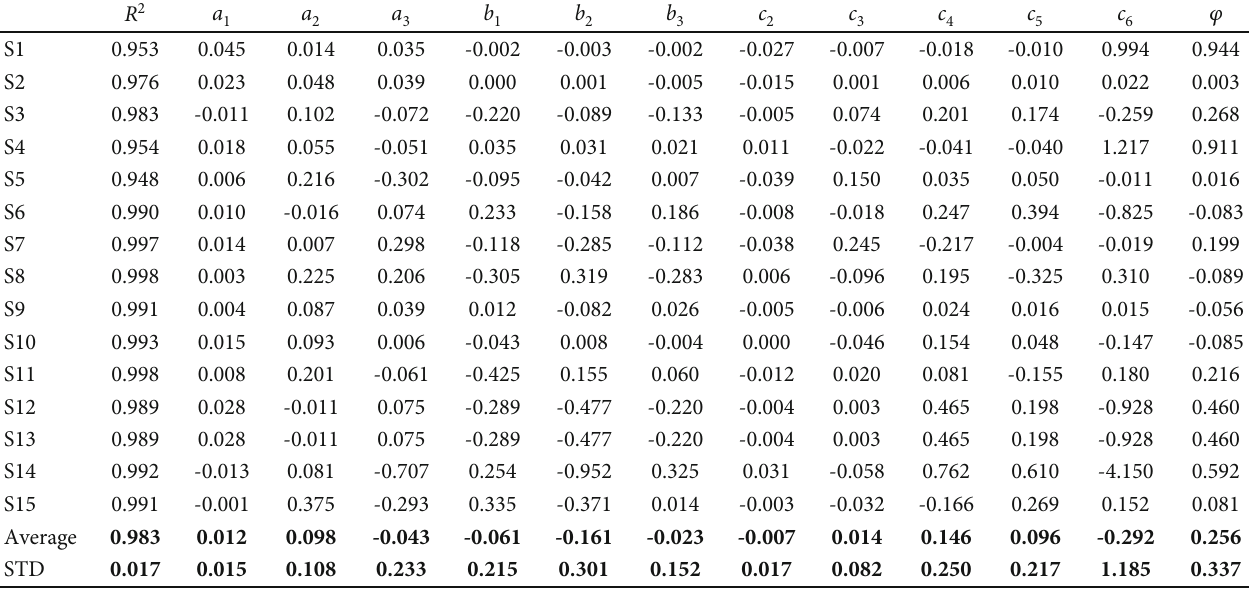
Table 5: Estimated material parameters of porcine sclera soft tissue loaded biaxially using polynomial (anisotropic) hyperelastic constitutive model including the coe ffi cient of determination ( R 2 ) of each specimen ( N = 15 ). The average constitutive ( a 1 , a 2 , a 3 , b 1 , b 2 , b 3 , c 2 , c 3 , c 4 , c 5 , φ , and R 2 ) parameters are also included. c 6 ,